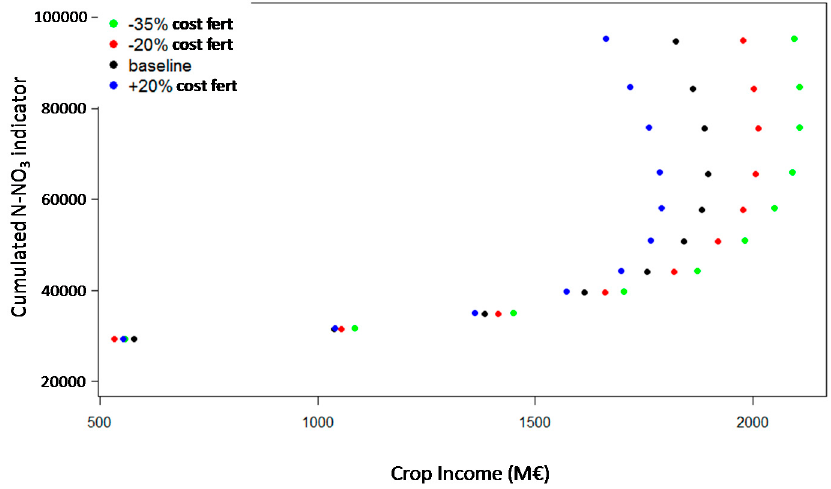
Figure 10. Sensitivity analysis for the fertilizer prices.